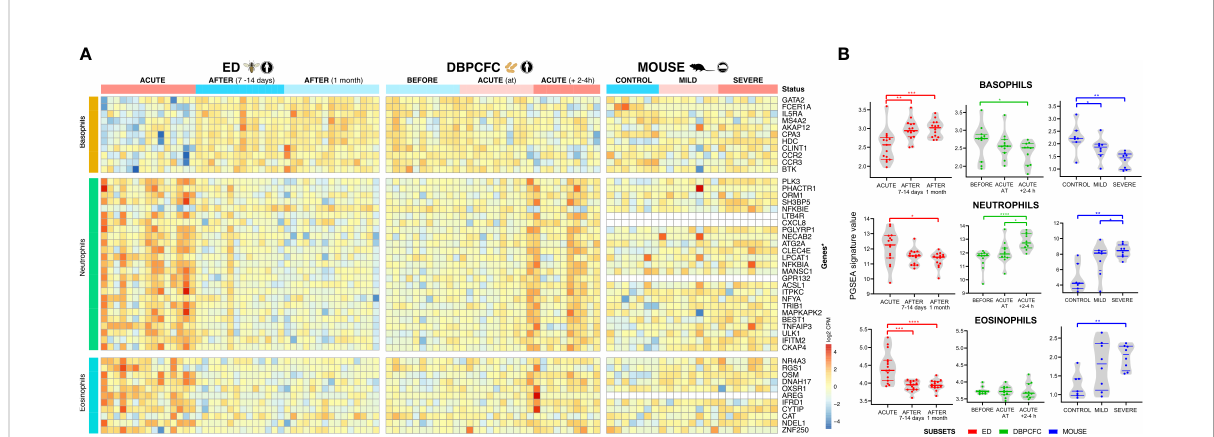
FIGURE 2 Immune cell-speci fi c pro fi le changes in peripheral blood during anaphylaxis. (A) Cell-speci fi c gene signatures of basophils, neutrophils and eosinophils are differentially expressed during anaphylaxis. (B) Changes in cell pro fi le in peripheral blood in different time points. No consistent differences were observed in expression signatures of B cells, dendritic cells, macrophages, monocytes, NK cells, T cells (CD4+ and CD8+, Th1 and Th2) (Details in Supplementary Tables 6, 7). ACUTE, acute anaphylactic episode; ED, Emergency Department; DBPCFC, double-blind placebo-controlled food challenge. *P <0.05, **P <0.01, ***P <0.001, and ***P <0.0001 by the Mann-Whitney